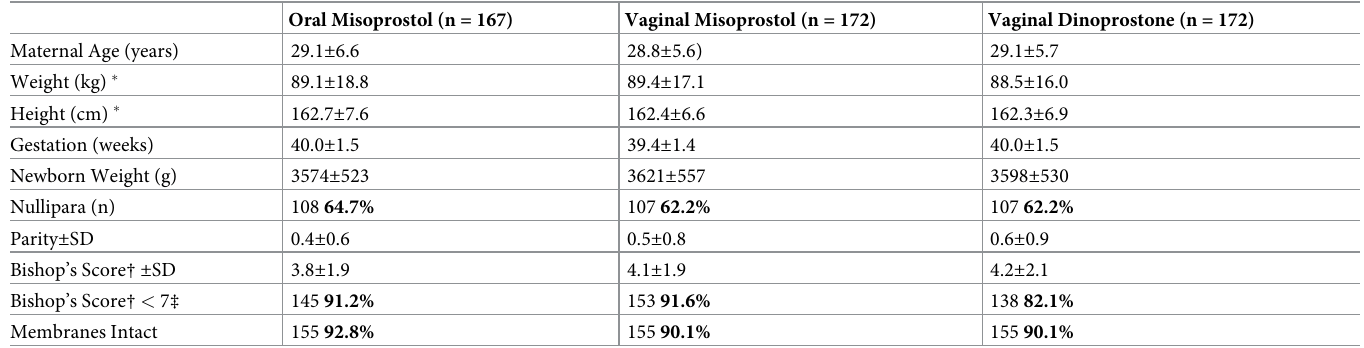
Table 1. Demographics (Mean ±